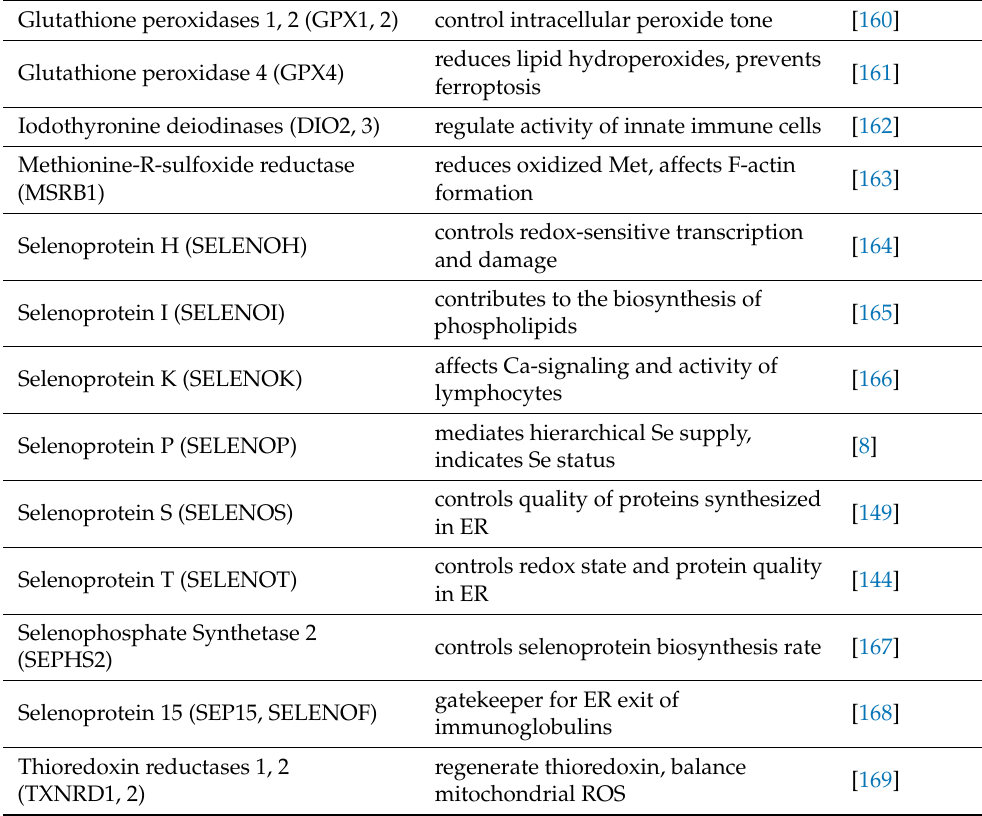
Table 1. Selenoproteins with particular functions in the immune system. Glutathione peroxidases 1, 2 (GPX1,